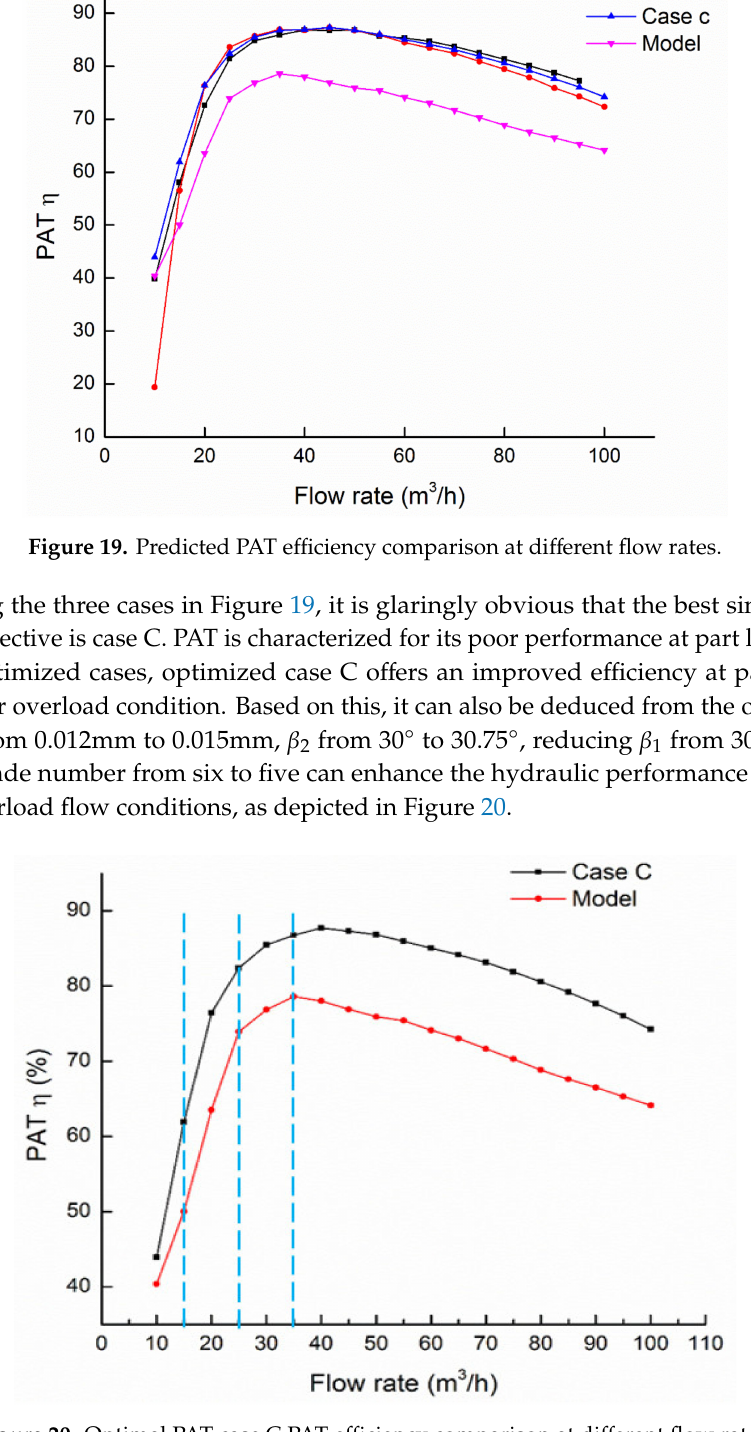
Figure 20. Optimal PAT case C PAT e ffi ciency comparison at di ff erent flow